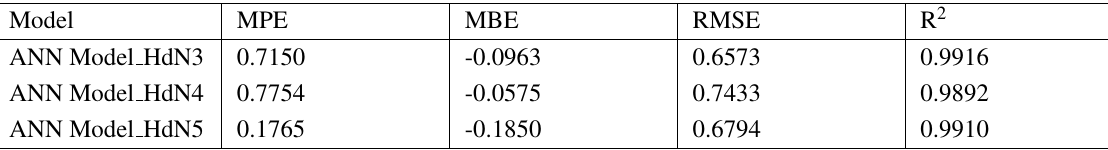
Table 1. Statistical indicators for three developed models